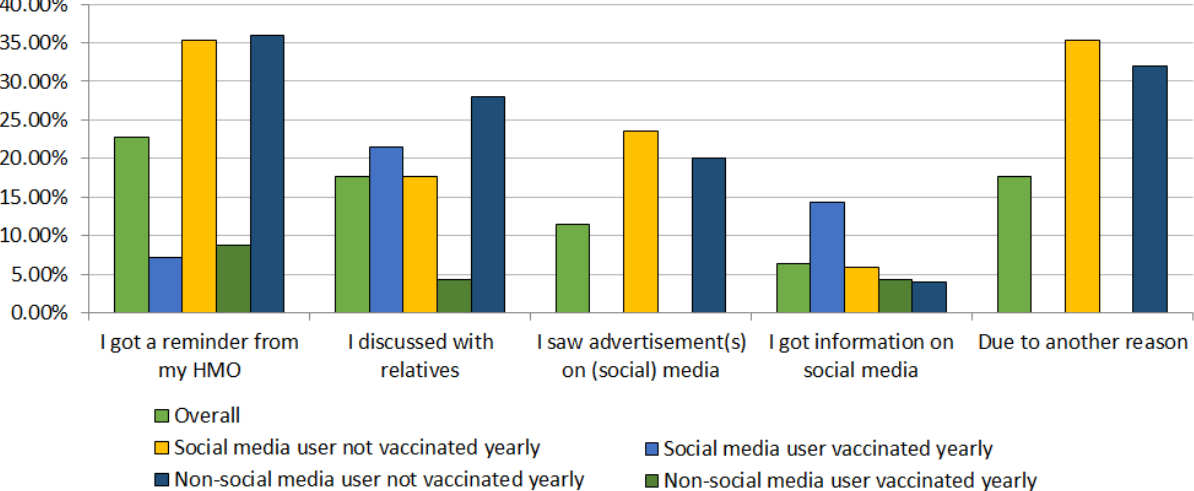
Figure 2. Reasons for receiving the influenza vaccine in 2019. The plot shows all participants and stratification by social media use and vaccination against influenza in 2019. HMO: health maintenance